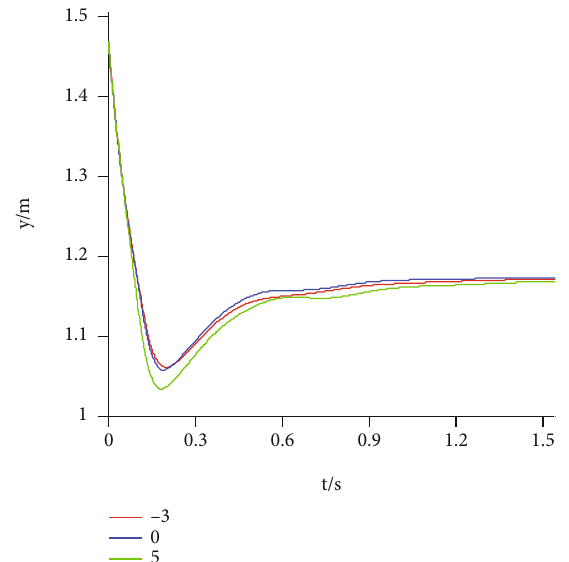
Figure 2: Body displacement versus time curve.